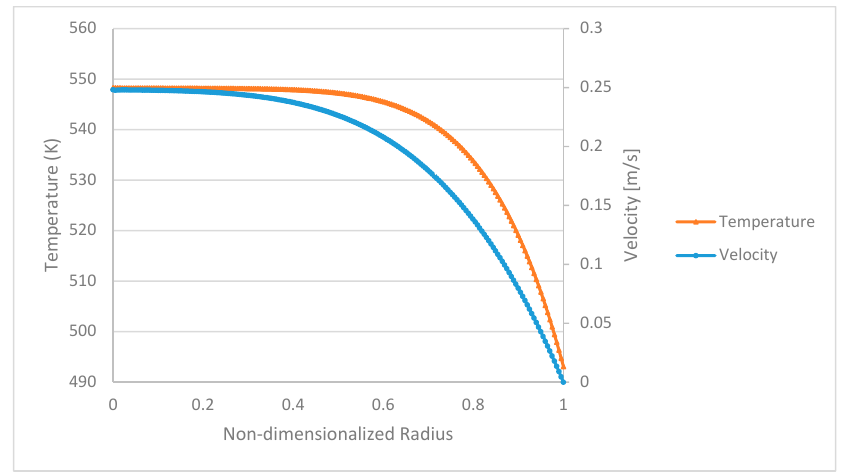
Figure 2. Velocity and temperature profiles at the entry of the die.